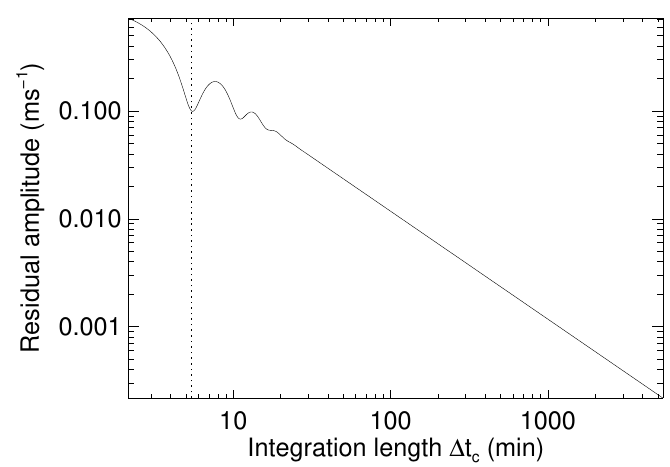
Figure 8. A subset of Figure 3 from [82], showing the residual RV amplitude of solar oscillations as a function of integration (i.e., exposure) time. A vertical dashed line shows the exposure length equal to 1/ ν max , where ν max is the peak frequency in the envelope of solar p-modes (and therefore sensitive to the specific stellar parameters) c (cid:13) AAS. Reproduced with